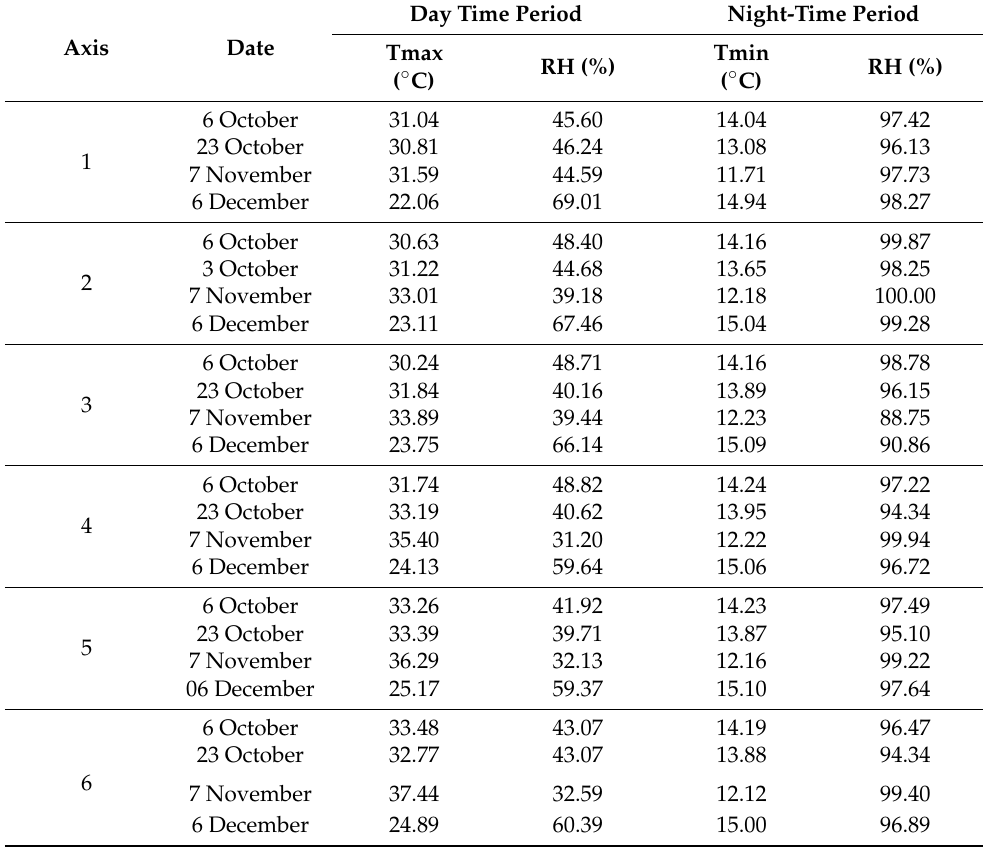
Table 7. Temperature and RH recorded inside the greenhouse during the case